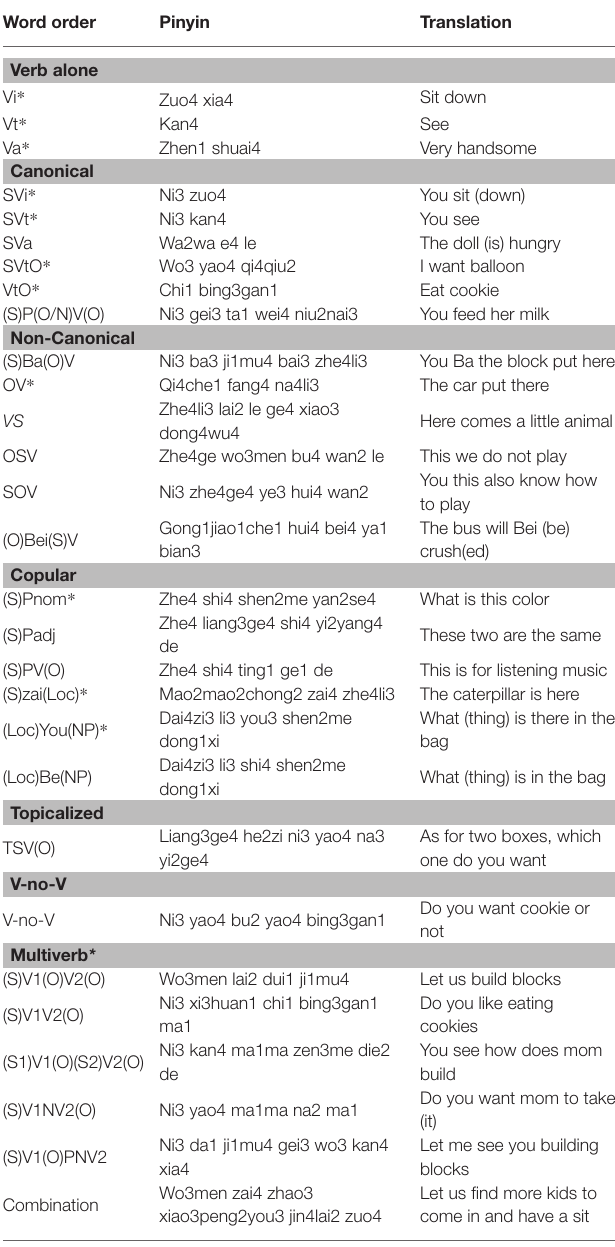
TABLE 1 | Word order